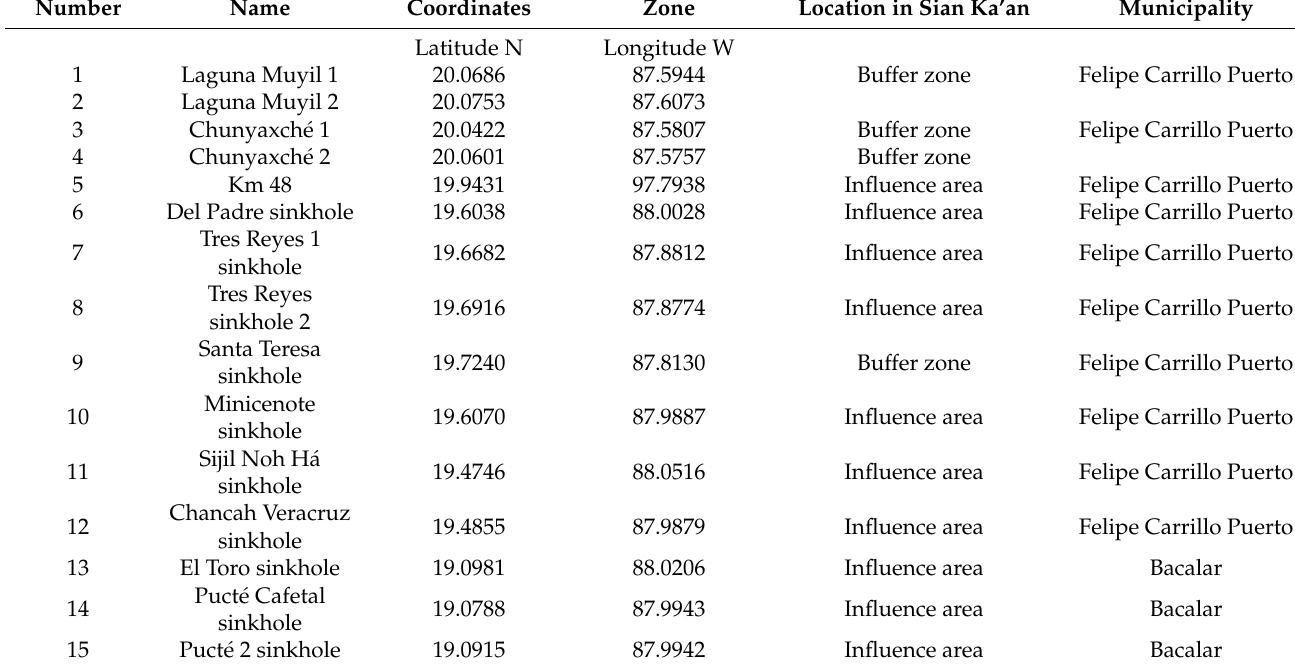
Table 1. Locations where the sampling was made. The buffer zone is systems within the reserve but near the limits of it. Influence area means less than 20 km from the limits of the polygon of the